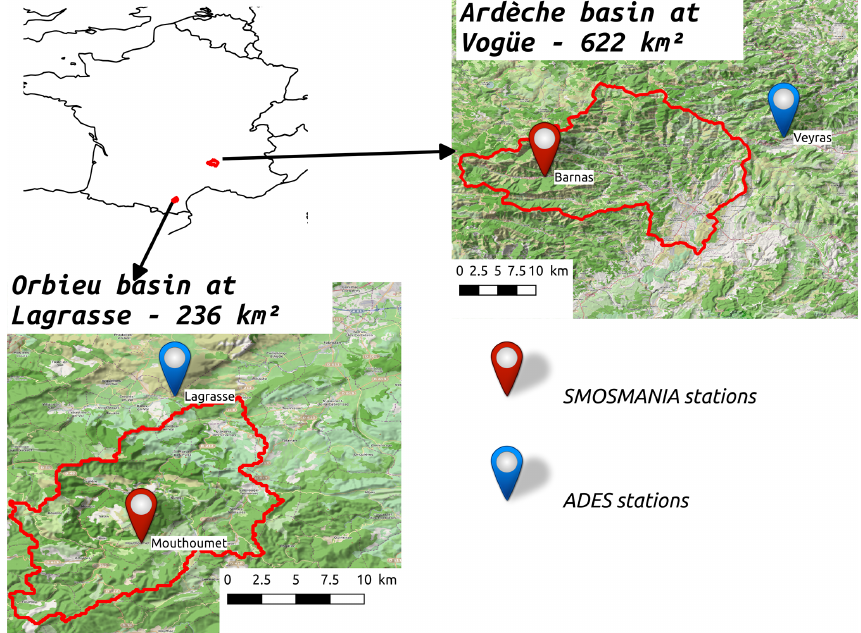
Figure 2. The two studied catchments located in southern France: the Ardeche river in Vogue and the Orbieu river in Lagrasse. Monitoring networks: soil water content (SMOSMANIA network stations) and the national groundwater ADES network stations (https://ades.eaufrance. fr/, last access: 15 March